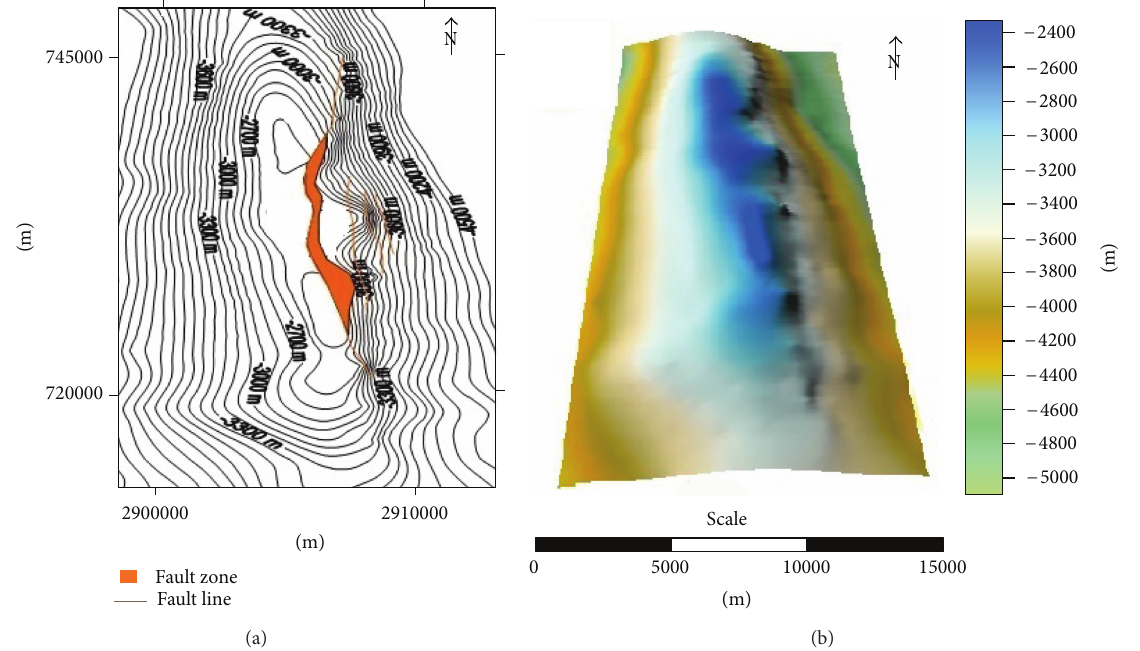
Figure 9: (a) Depth structure map on the top of the Lower Gas Sand (R5), Contour interval 100 ms. (b) Subsurface relief map on the top of the Lower Gas Sand